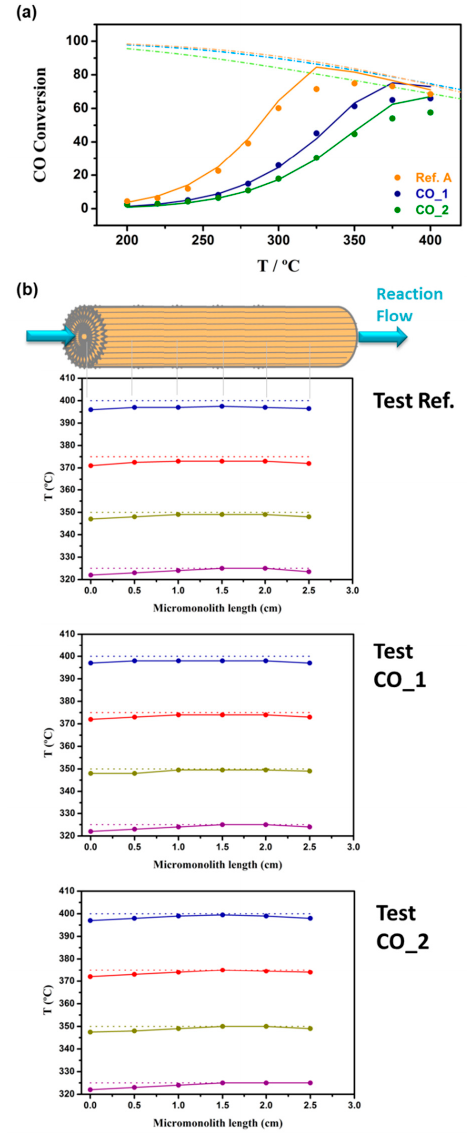
Figure 6. ( a ) CO Conversion vs Temperature plot for several tests. The experimental data are plotted as dots. Calculated conversion data (Equation (15)) are plotted as solid lines. The equilibrium curves are plotted by dashed lines. ( b ) Temperature profile along the micromonolith length during WGS reaction kinetic tests. The real temperatures (straight lines) are measured by the mobile thermocouple in the central channel of the monolith. The temperature set points (dotted lines) are measured by the fixed thermocouple in the internal wall of the furnace. A maximal deviation of ±4 °C at the micromonolith endings are found at the highest tested temperatures. Such an excellent temperature control, which is due to the conductivity of the